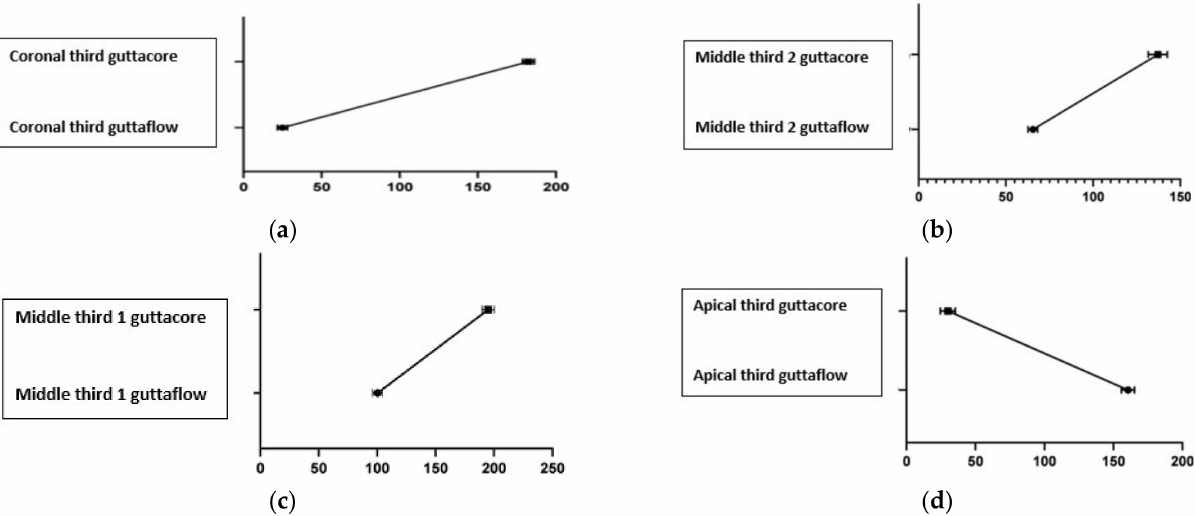
Figure 11. ( a ) Percentage (%) of voids in the coronal third: 12.1% group T–1.6% group G; ( b ) Percent- age (%) of voids in the middle third 2: 20.5% group T–6.8% group G; ( c ) Percentage (%) of voids in the middle third 1: 17.25% group T–12.5% group G; ( d ) Percentage (%) of voids in the apical third: 5% group T–26% group